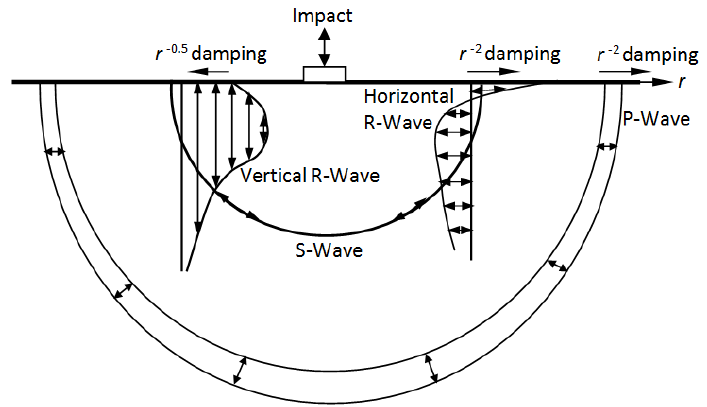
Figure 4. Distribution of stress waves from a vertical load on a homogeneous elastic half-space (after Richart et al.